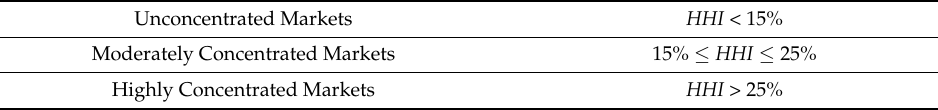
Table 5. Interpretation of “ HHI ” a